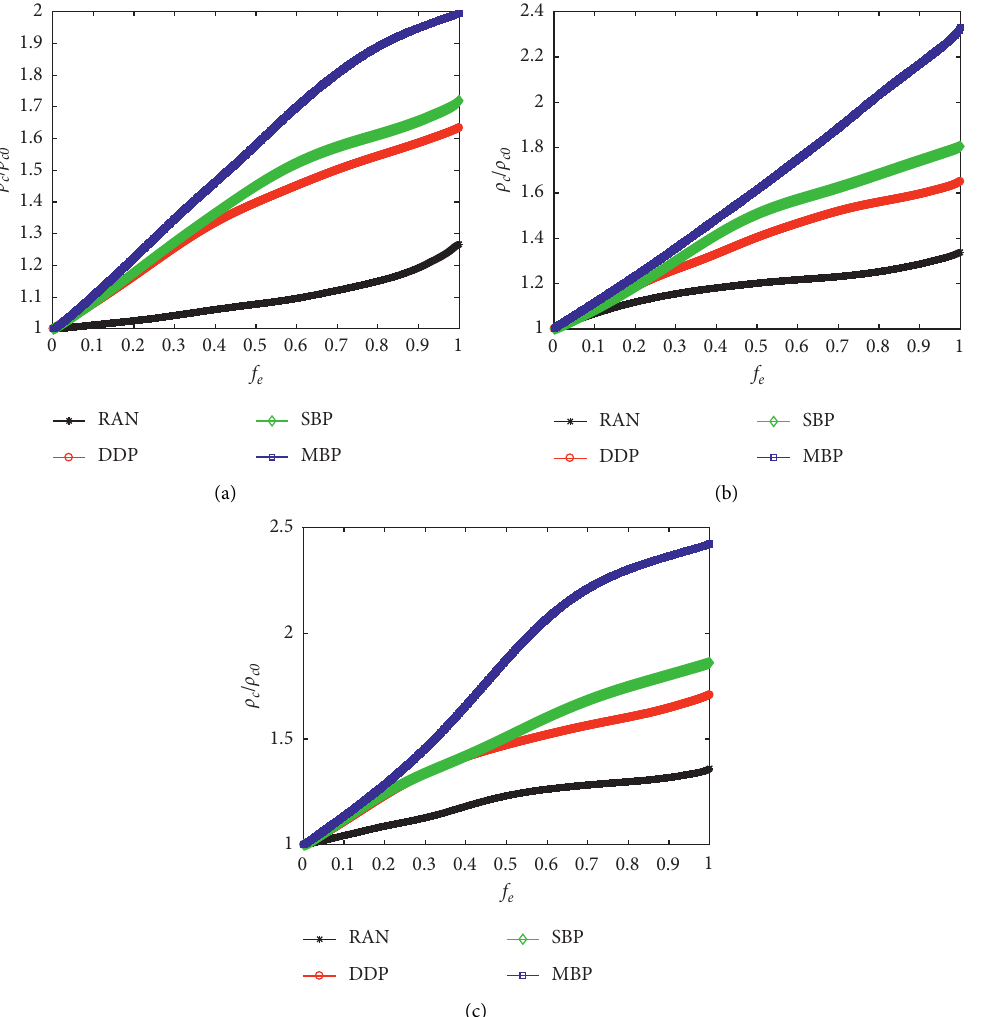
Figure 1: The enhancement of our strategies in multiplex network: (N) � 128, (m) � 4, < (k) > � 16, and (Z) (Z) in � 8, (b) (Z) in � 11, and (c) (Z) in �